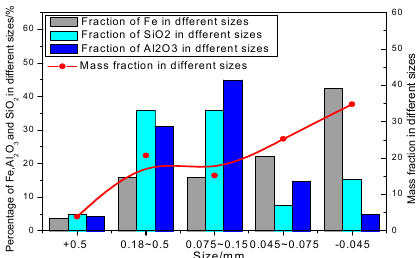
Figure 1. The size distribution of nickel slag and the fraction of Fe, SiO 2 and Al 2 O 3 in the different sizes.